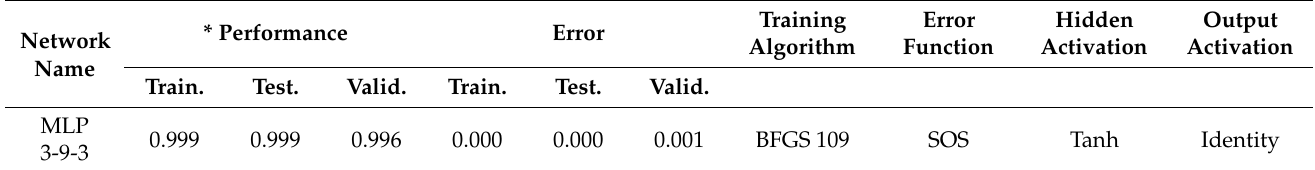
Table 3. Artificial neural network model summary (performance and errors).